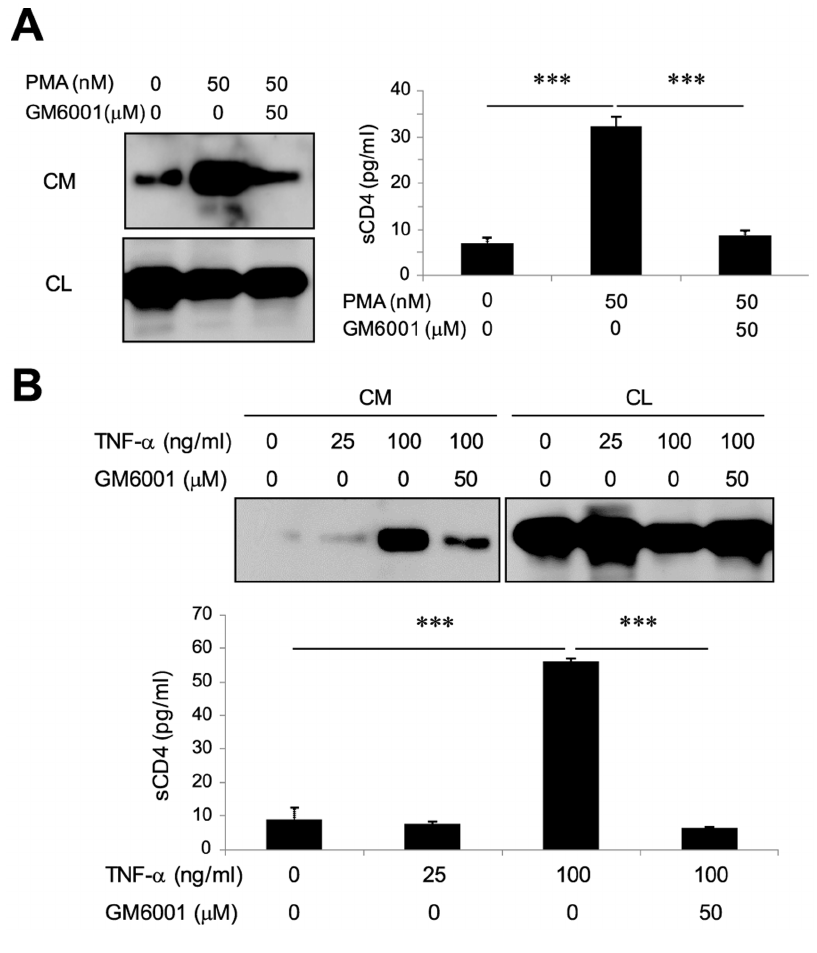
Figure 3. Production of sCD4 by primary CD4 + T cells is mediated by MMP-like shedding. (A, B) CD4 + T cells were stimulated by 50 nM PMA (A) or TNF- a (25 and 100 ng/ml) (B) in the absence or presence of GM6001 (50 m M) for 3 hr. CM and CL were collected for ELISA and WB analysis. Dunn’s multiple comparisons post-test p values between groups show ***P , 0.001.